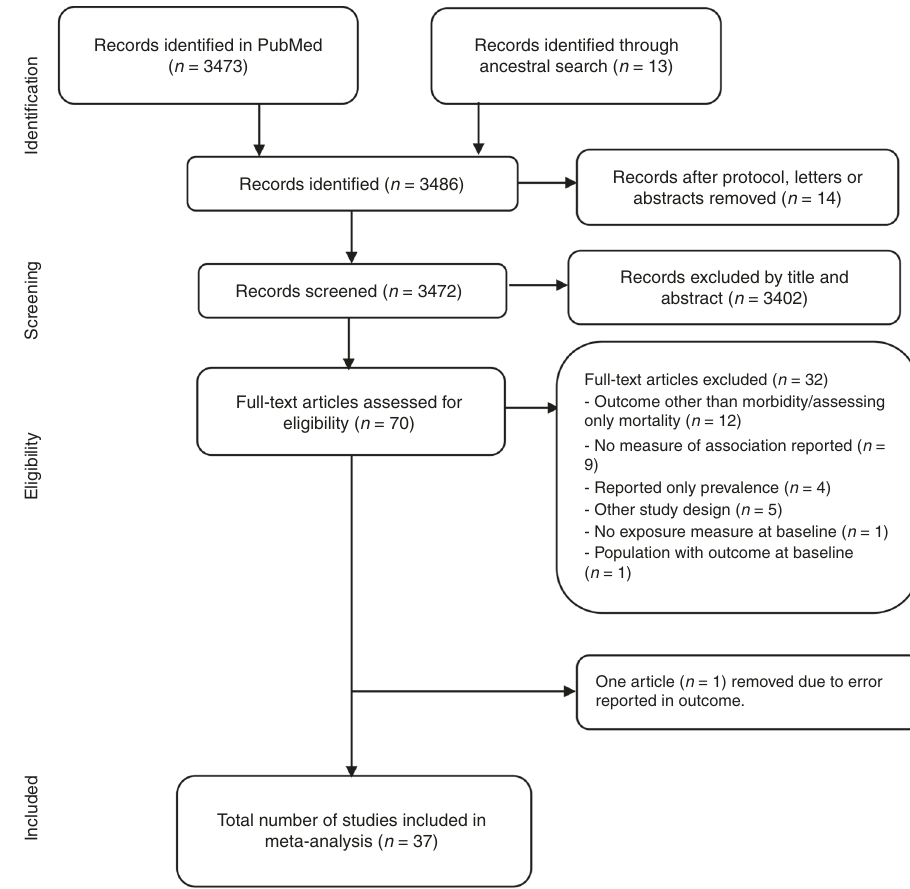
Fig. 6 Outline of study selection procedure. Source data are provided as Source Data fi